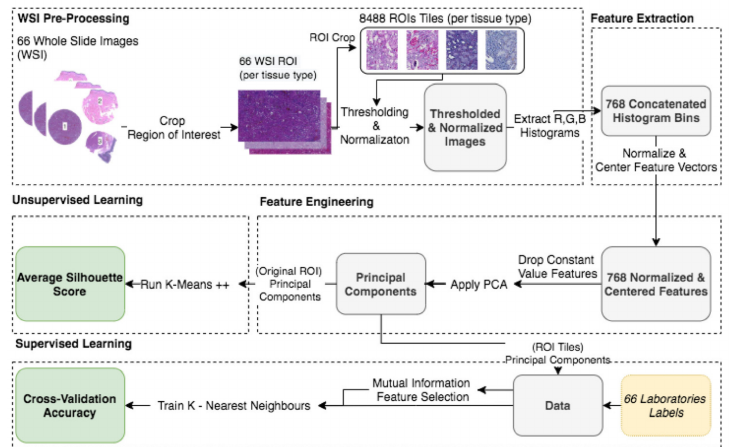
Figure 2. Experiment dataflow